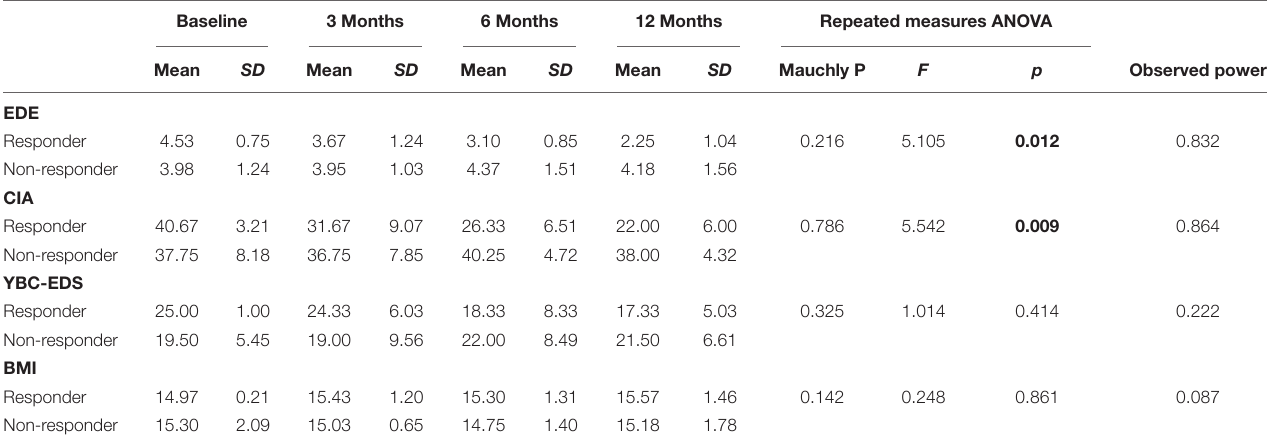
TABLE 5 | Change in eating disorder pathology over time.